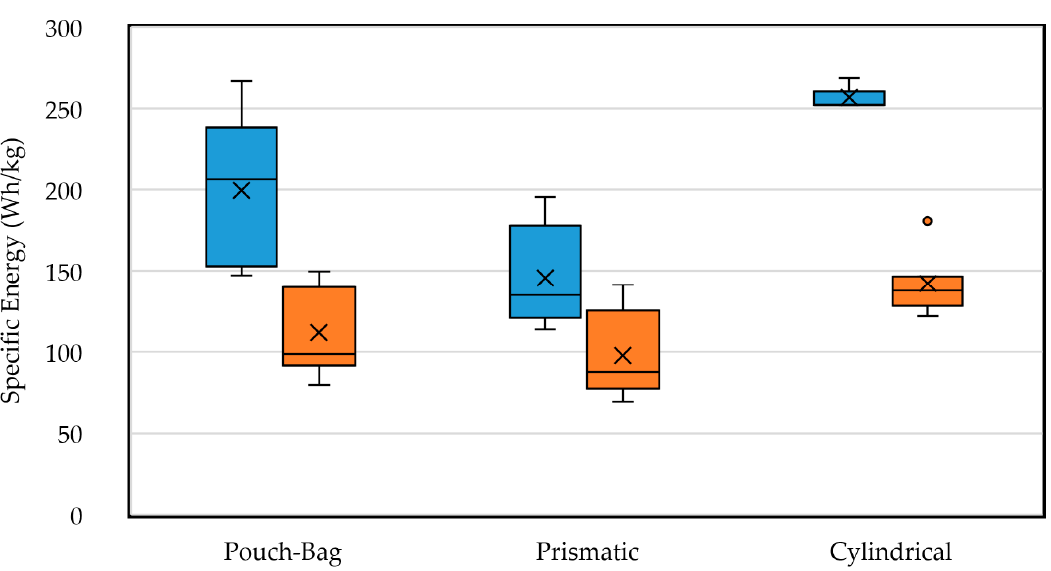
Figure 11. Cell Type and Energy Density on Cell Level (Blue) and System Level (Orange) from the 25 Vehicles Assessed.